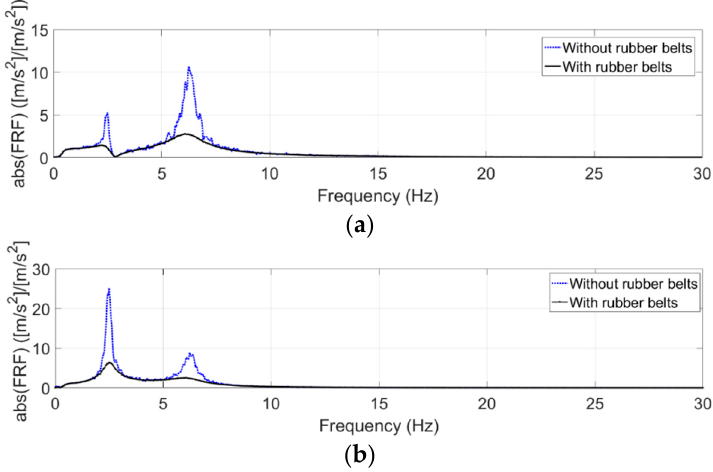
Figure 8. FRF in horizontal direction: ( a ) between the seismic plate and the upper plate; and ( b ) between the seismic plate and the head of the statue.